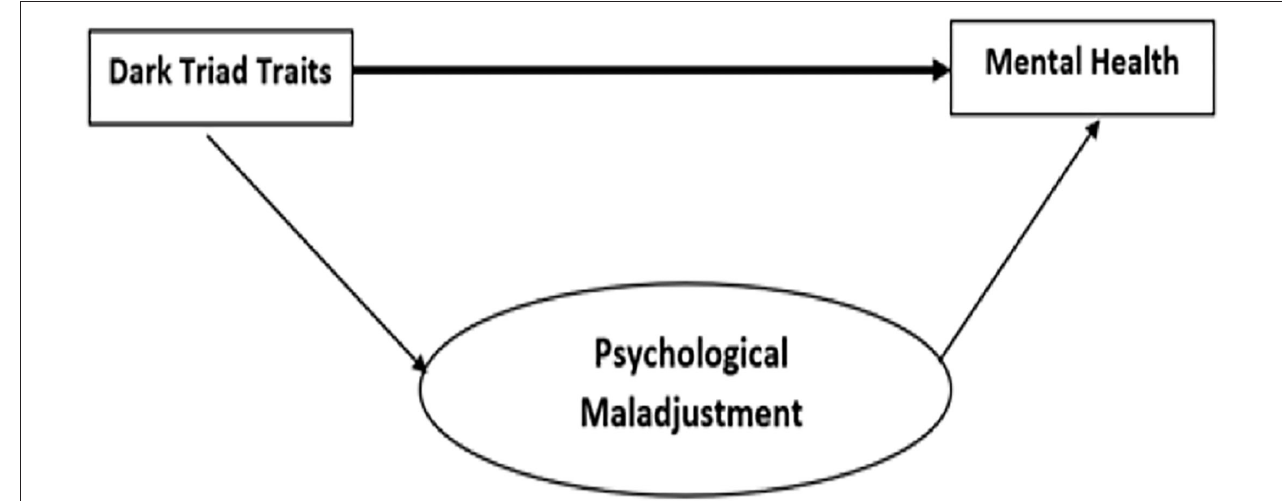
FIGURE 1 | Conceptual model of the